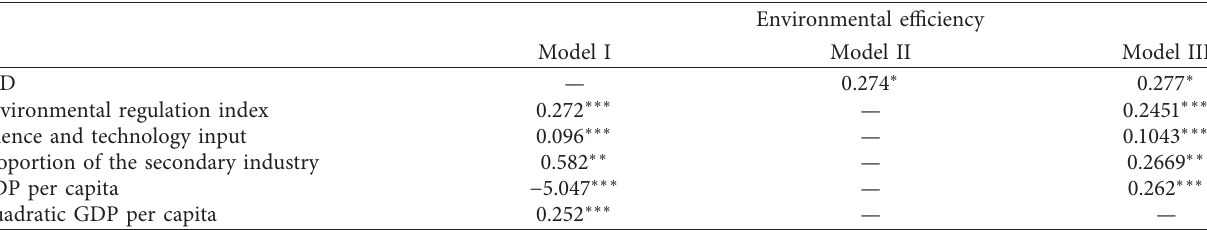
Table 2: The impact of the construction of sustainable development pilot zone on environmental